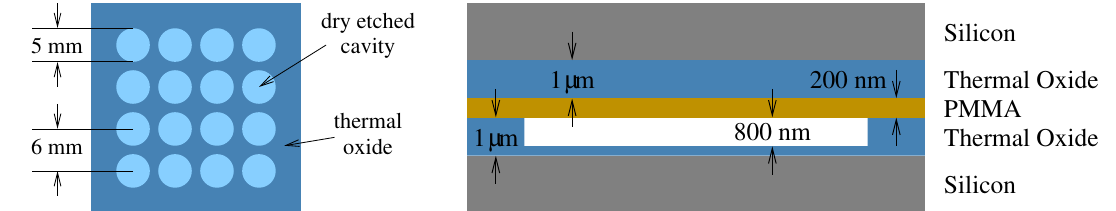
Figure 1. Top ( left ) and cross-sectional ( right ) views of the proposed Capacity Micromachined Ultrasonic Transducer (CMUT), showing device dimensions.